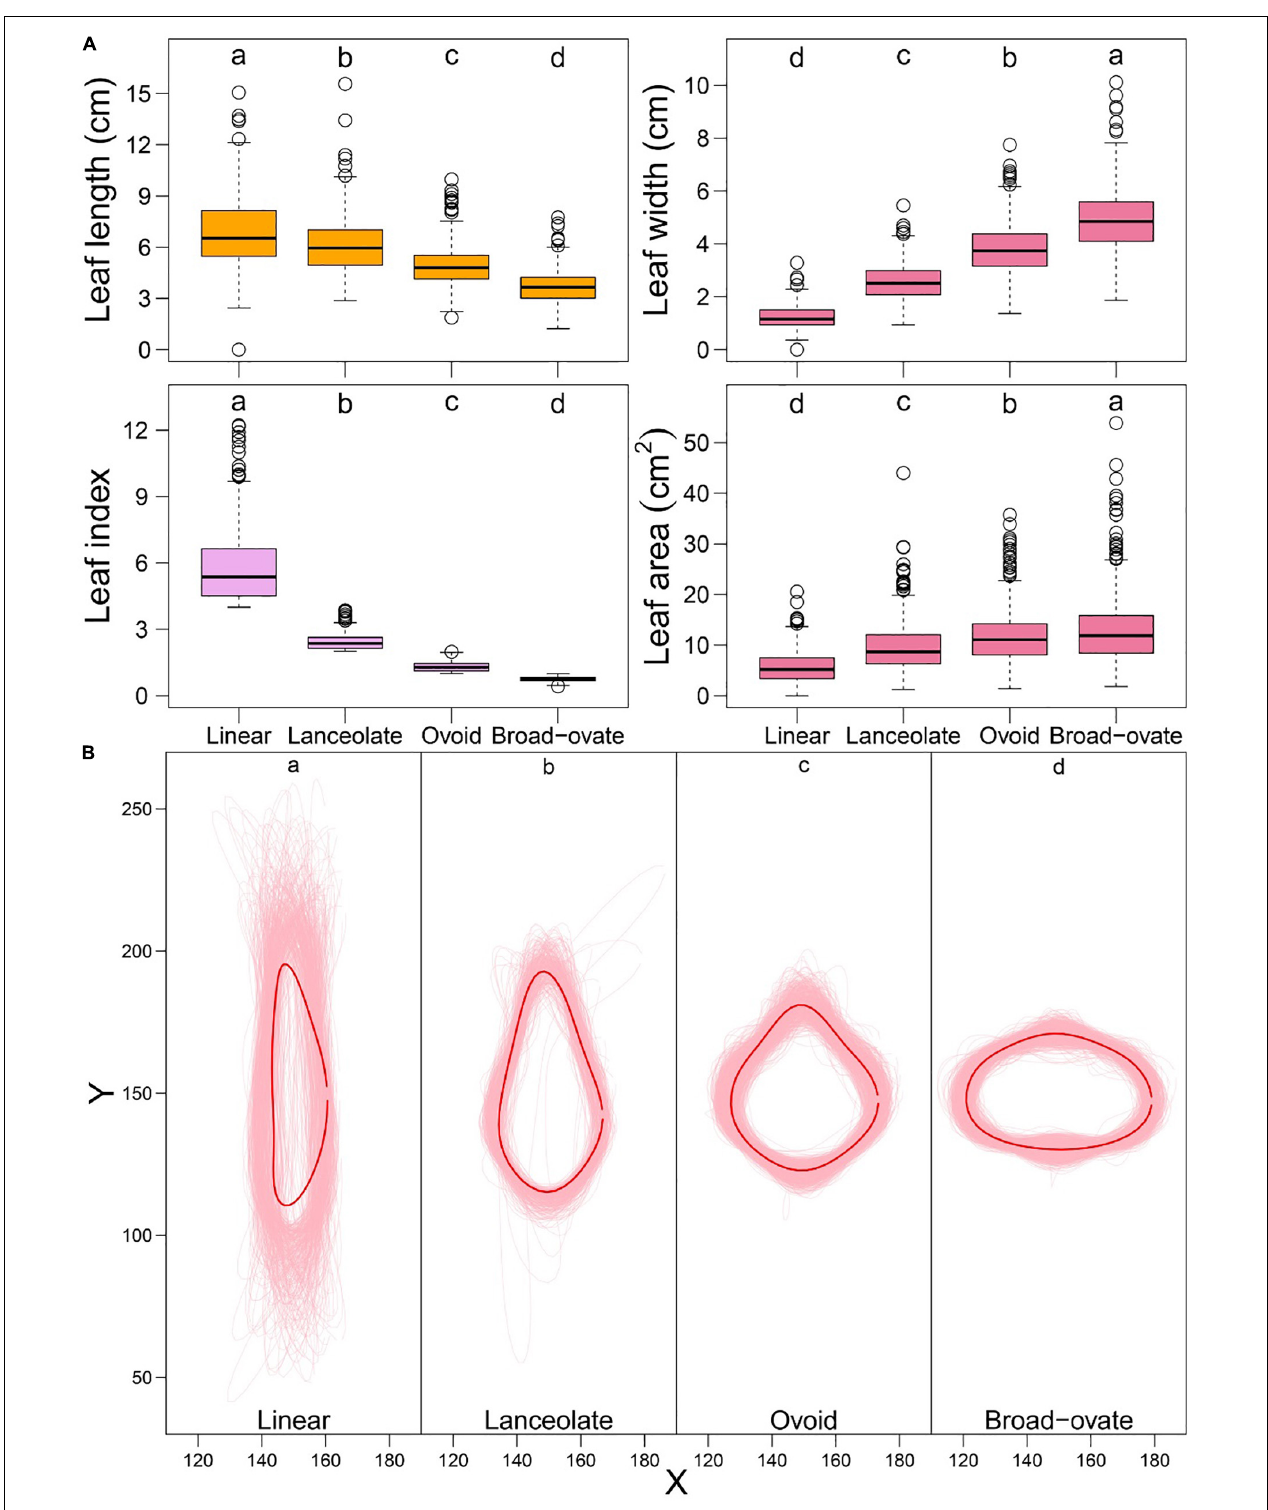
FIGURE 2 | Descriptive data and shape distribution and MANOVA test for heterophylly, the letters (a, b, c, and d) indicate multiple comparison results at the significant level 0.05. (A) Descriptive data distribution and MANOVA for the descriptive data of heterophylly. (B) Shape distribution and MANOVA for the shape of heterophylly. The light pink thin line denotes the shape of heterophylly for each genotype, red thick line denotes the mean shape of all genotypes for four types of heterophylly.